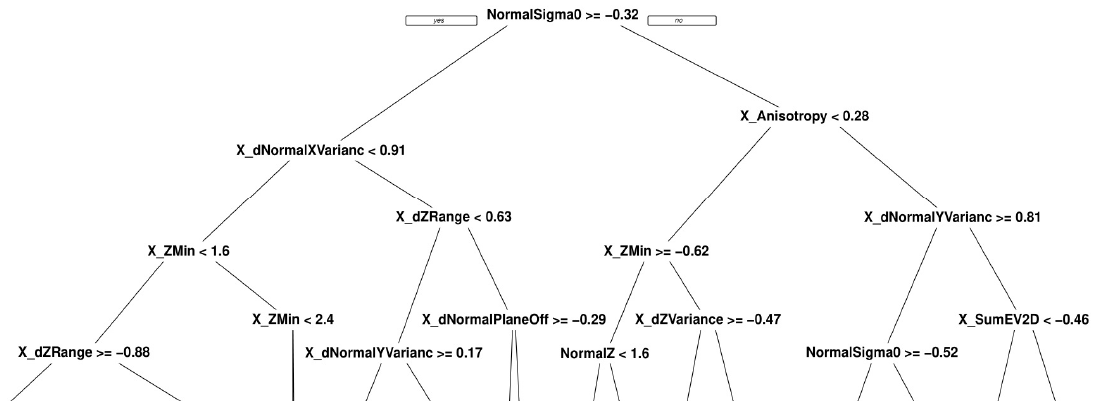
Figure 20. Classification model ‐ detail of decision trees.